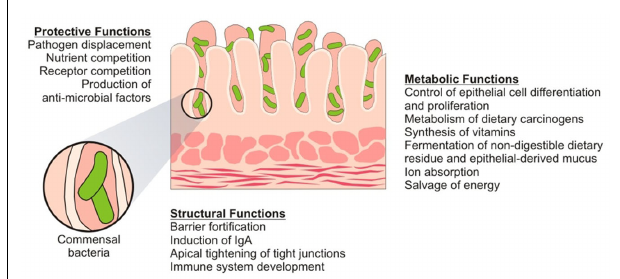
FIGURE 2 | Function of the intestinal microbiome. Commensal bacteria exert a miscellany of protective, structural, and metabolic effects on the intestinal